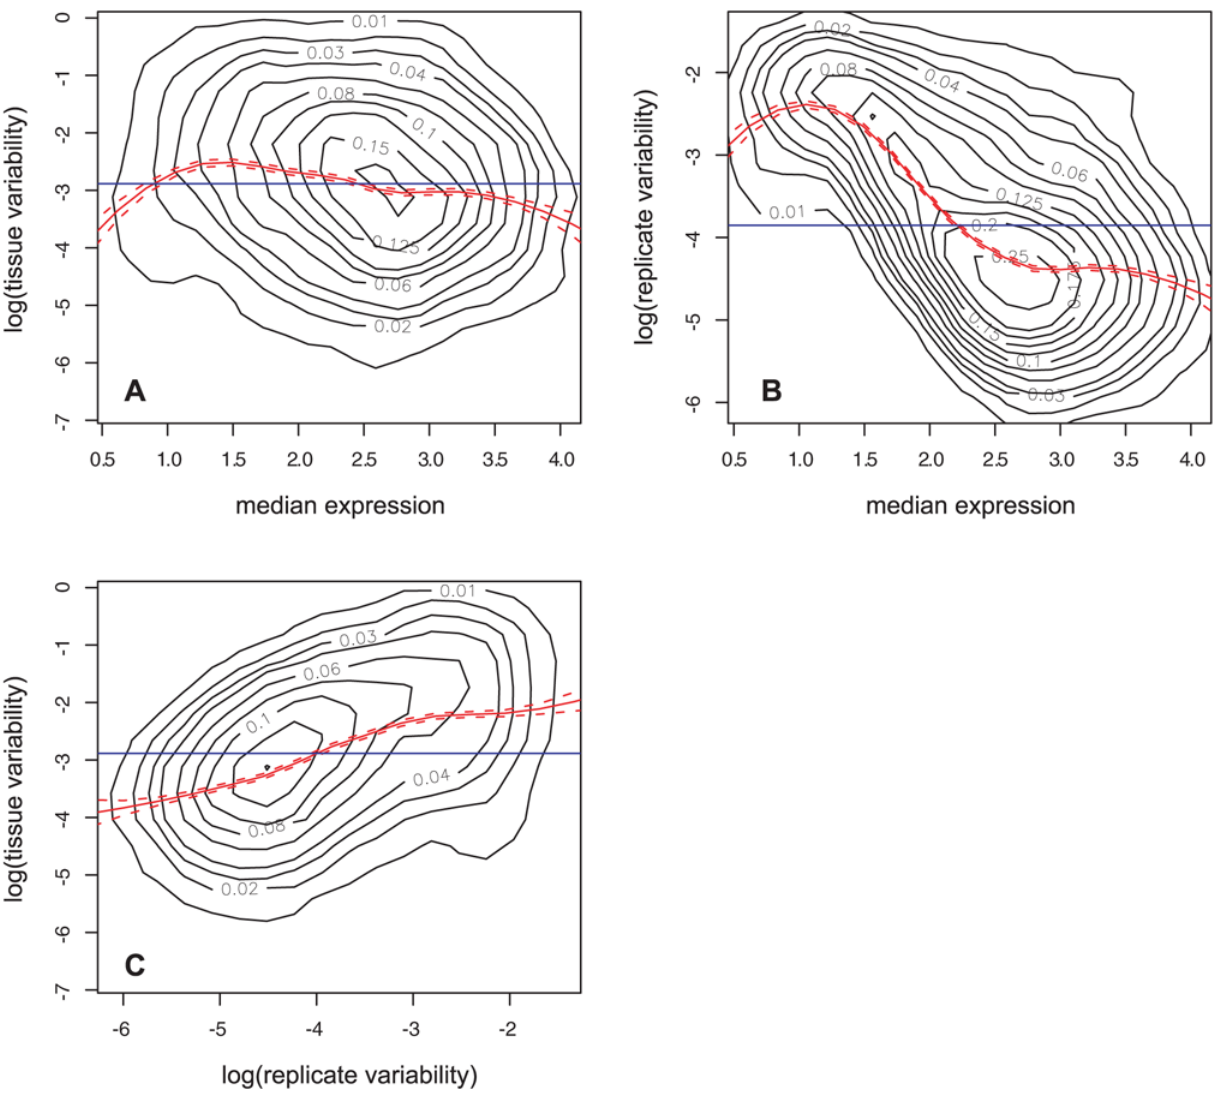
Figure 3. Inter-dependencies between inter-tissue median, and inter-tissue variability, and noise of expression. Relationships between our gene expression measures for expression level (median across tissues), variability (log of variability between tissues) and noise (log of variability between biological replicates).